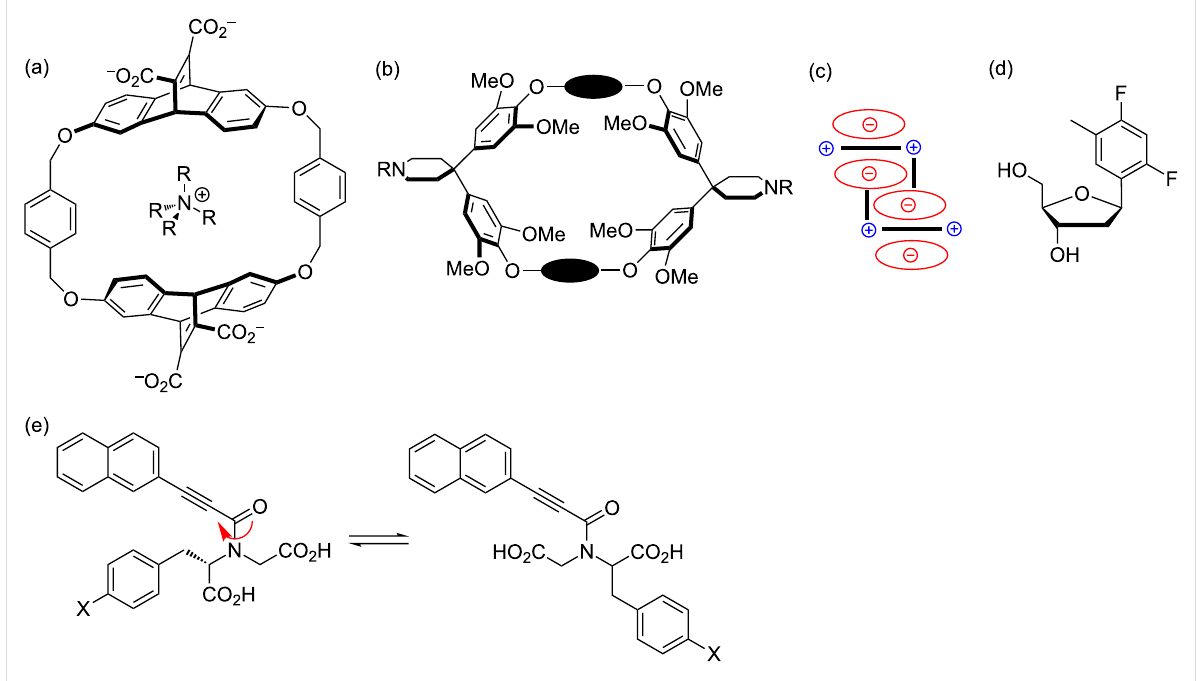
Figure 3: Work by others that inspired my interests. (a) Cyclophane receptors from Dennis Dougherty’s group in the late ‘80’s and early ‘90’s that demonstrated cation– π interactions [2]. (b) Cyclophane receptors from the Diederich group in the late ‘80’s and early ‘90’s that demonstrated the “nonclassical hydrophobic effect” [3]. (c) The Hunter-Sanders Model for π – π stacking from 1990 [4]. (d) Kool’s nonpolar isostere of thymidine from 1995 [5].(e) Gellman’s model for π – π stacking in aqueous solution